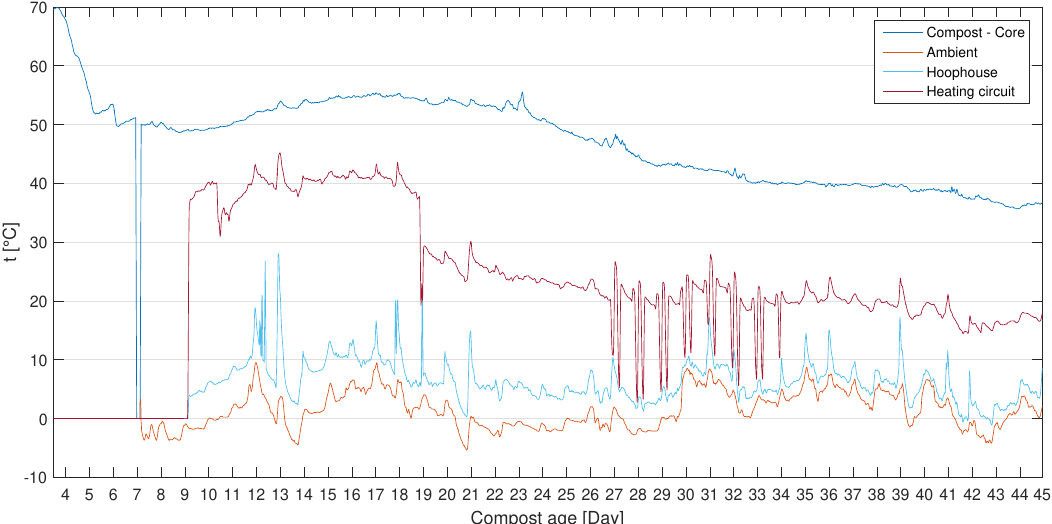
Figure 15. Core temperature of the pile, hoop house and the heating circuit compared to ambient during days 4 and 45. Note that the temperature drop during day 7 indicates sensor or connection failure on 1-wire